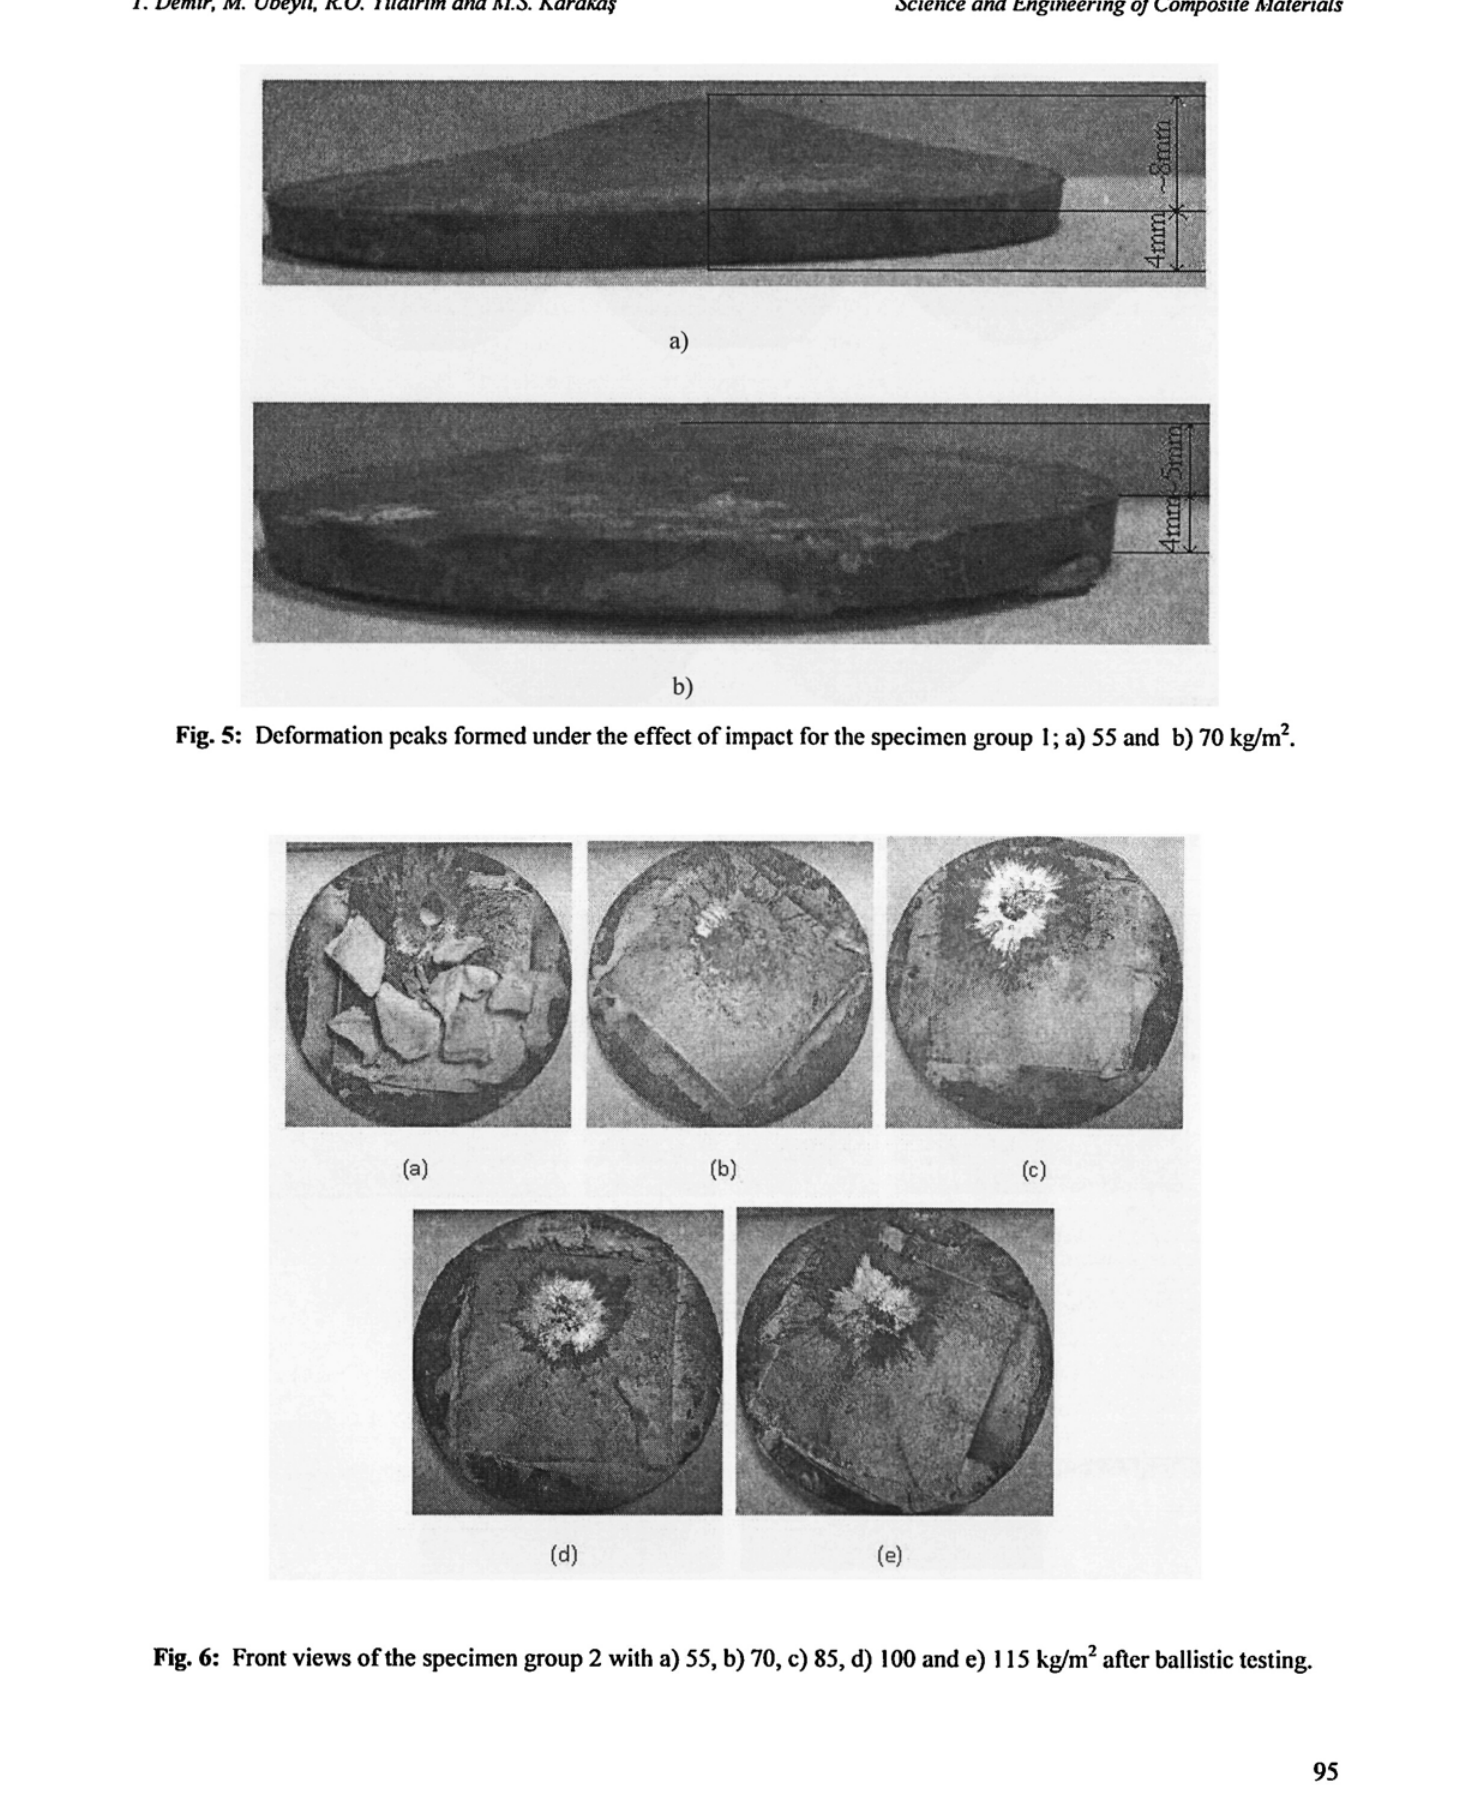
Fig. 6: Front views of the specimen group 2 with a) 55, b) 70, c) 85, d) 100 and e) 115 kg/m 2 after ballistic